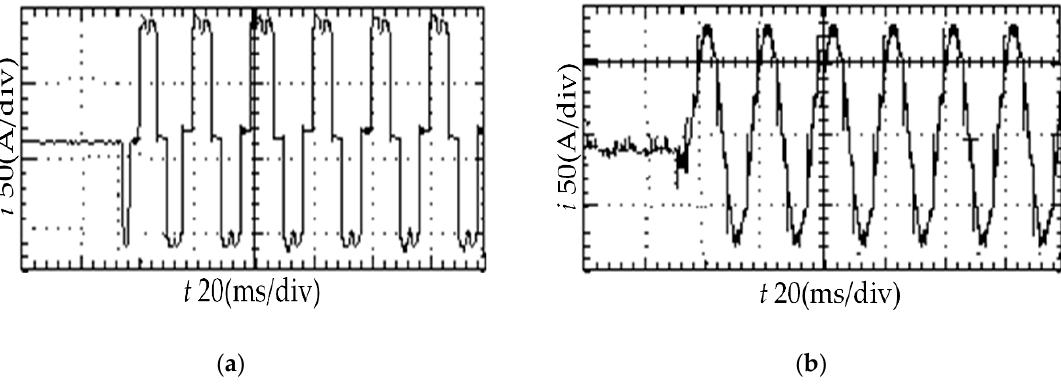
Figure 11. Load and source current waveforms during loading. ( a ) The load current waveform during load on; ( b ) The source current waveform during load on.